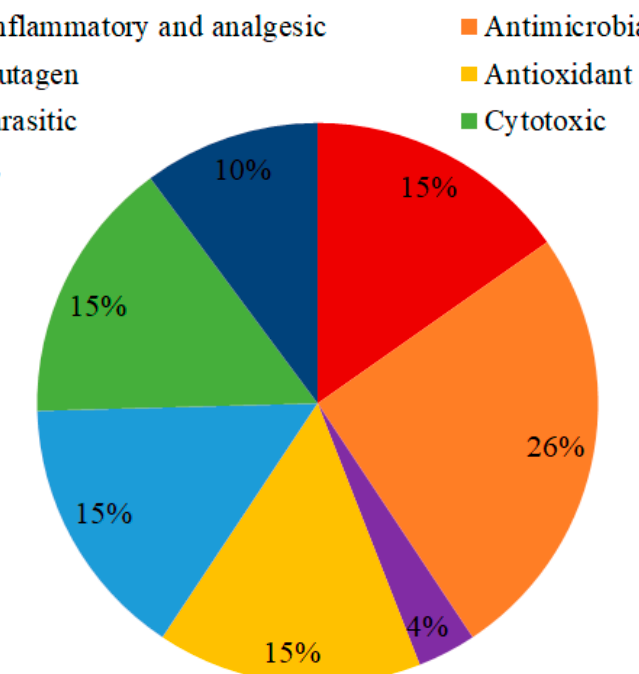
Figure 1. Biological and pharmacological activities reported for Miconia species in the last twenty-one years (2001–2021).